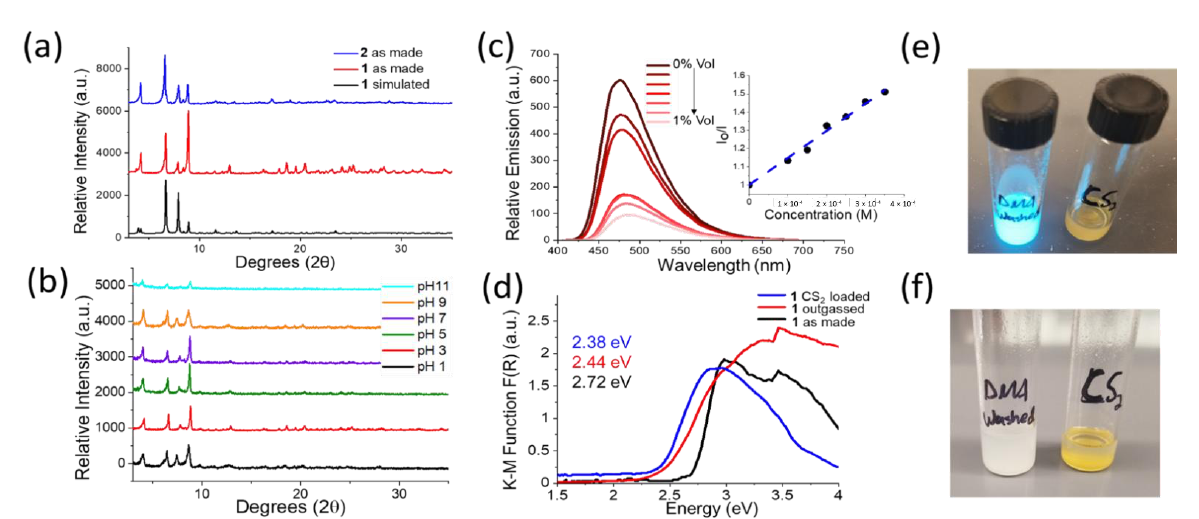
Figure 2. ( a ) PXRD patterns of simulated 1 compared to the experimental patterns of 1 and 2 . ( b ) PXRD patterns of 1 after exposure to different pH values. ( c ) Luminescence quenching profile of 1 when exposed to increasing concentrations of CS 2 in DMA (inset: the Stern–Volmer plot). ( d ) Optical band gaps of 1 in different forms. A shift in optical band gap of 1 after exposure to CS 2 was observed. ( e , f ) Images of 1 before and after exposure to CS 2 : under UV excitation ( e ) and under daylight ( f ).